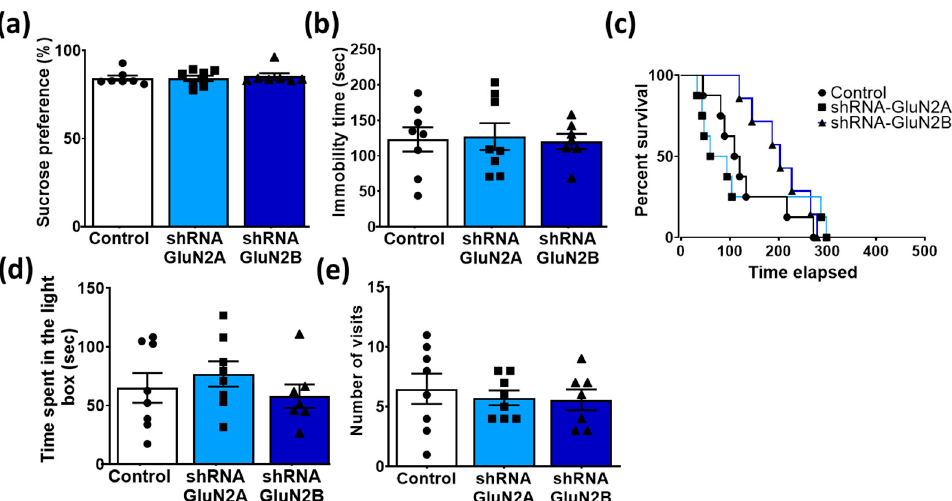
Figure 8. Antidepressant- and anxiolytic-like effects of AdipoRon were independent of hippocampal NMDA receptors. The effects of sub-chronic (7 days) AdipoRon treatment were not significantly affected by knockdown of the NMDA receptor subunit (GluN2A and GluN2B), as no significant alteration was observed in ( a ) the sucrose preference in the SPT, ( b ) immobility time in the FST, ( c ) latency to eat in the NSF test, and ( d ) time spent and ( e ) number of visits to the light compartment of the LDB test, compared with AdipoRon-treated animals with intact NMDA receptor subunits (Control). One-way ANOVA. Data presented as mean ± SEM.